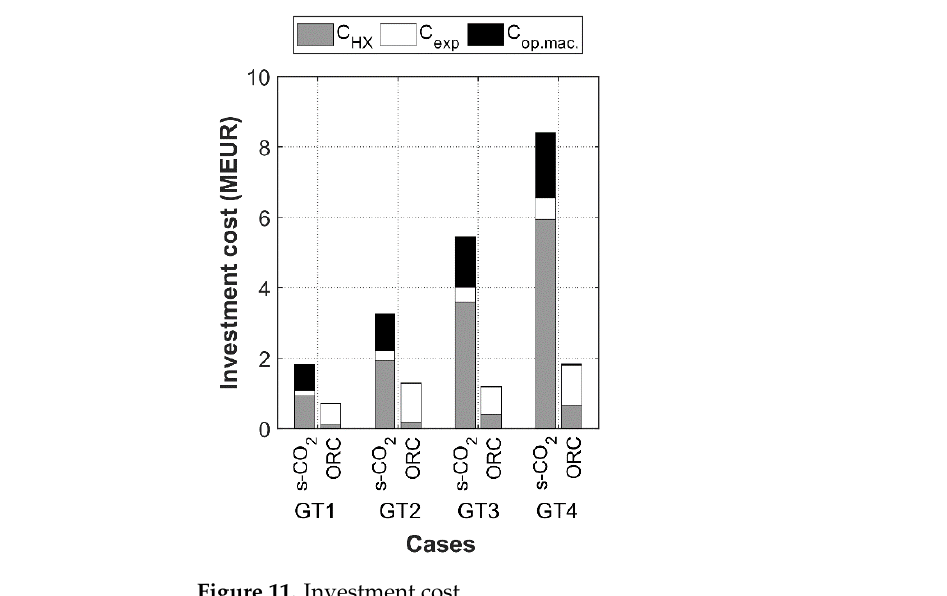
Figure 11. Investment cost.